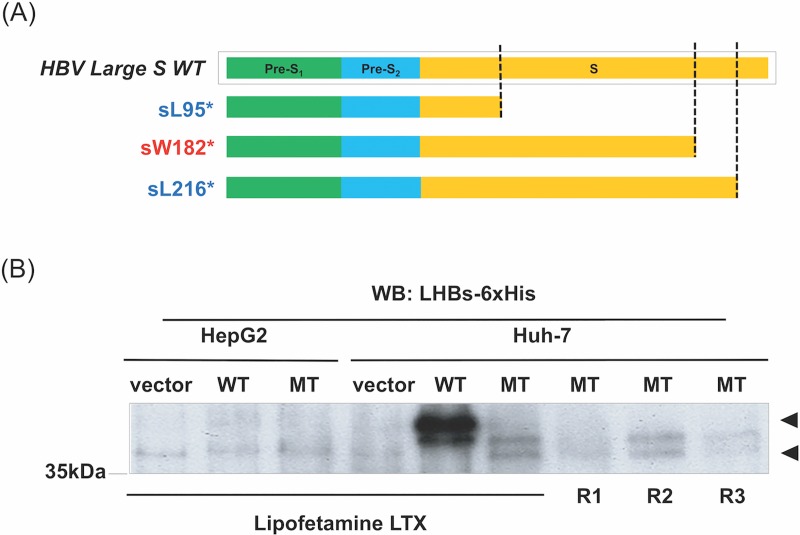
Expression of the LHBs sW182* truncation mutant in cultured liver cells.(A) Schematic diagram of the LHBs protein and its truncation mutants identified from the liver of HBV-related HCC [19]. The truncation mutants were named after the stop codon at the corresponding site for each amino acid. A nonsense mutation at the codons for L95, W182 and L216 resulted in sL95*, sW182* and sL216*, respectively. (B) HepG2 and Huh-7 cells were transfected with control vector, 6xHis-tagged wild-type (full length) LHBs (WT) or sW182* mutant (MT) using different transfection reagents Lipofectamine LTX, R1, 2, 3). The protein was detected by Western blot with the 6xHis antibody. The arrowheads indicate the position of the wild-type and mutant protein on the blot.